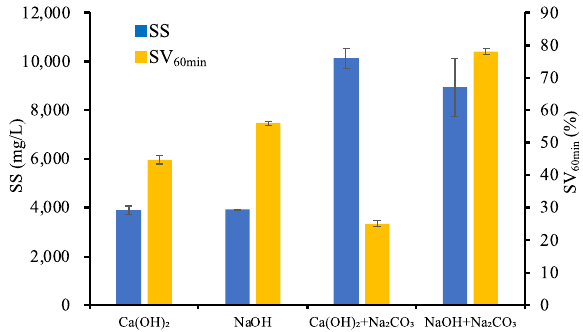
Fig. 2 Suspended solids (SS) and sludge volumes after 60 min of settling time (SV 60min ) for each alkaline agent after pH adjust- ment to 11.0. ( n = 3, means ± standard